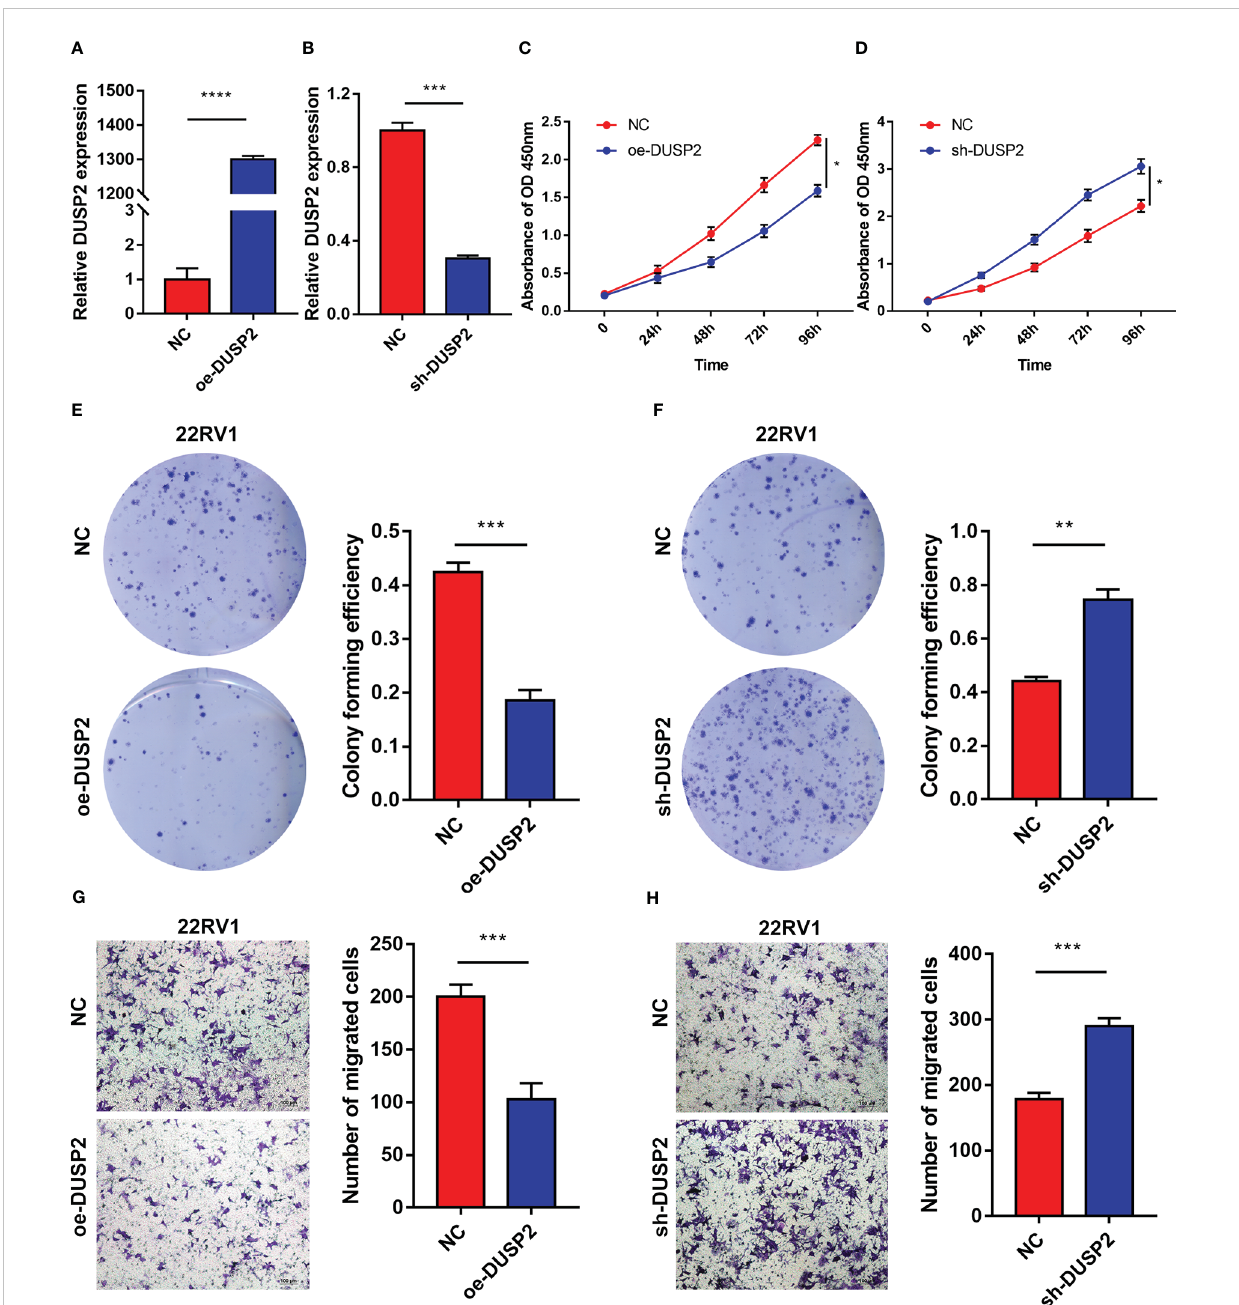
FIGURE 9 The DUSP2 regulated the proliferation and migration of PCa cells. (A, B) q-PCR was performed to determine the overexpression and knockdown ef fi ciencies of DUSP2 in 22RV1 cells. (C – F) CCK8 assays and colony formation assays were used to determine the proliferation ability of 22RV1 cells after overexpressing or silencing DUSP2. (G, H) Migration capacity of cells with DUSP2 overexpression or knockdown based on transwell assays. *P <0.05, **P < 0.01, ***P < 0.001,